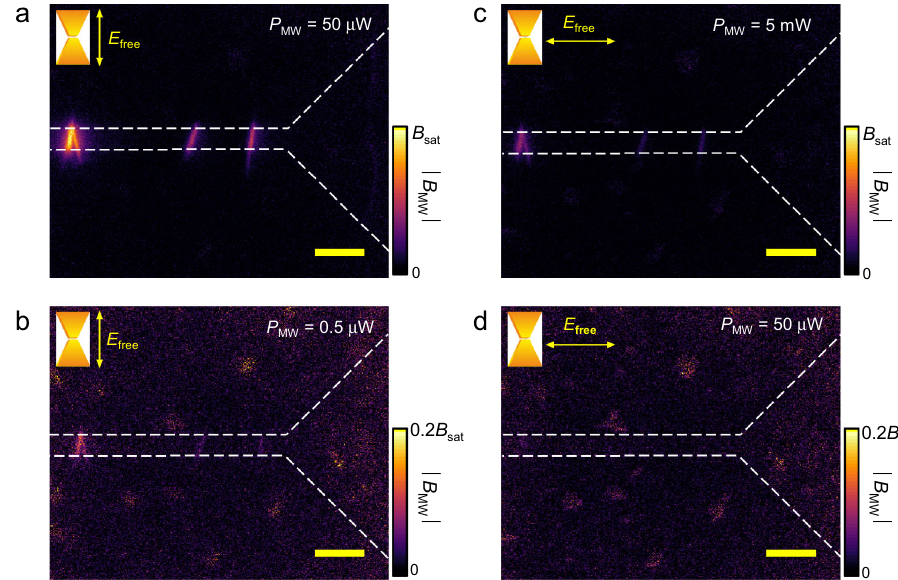
Fig. 4 The localized microwave fi eld distribution is changed with the polarization of the free-space microwave. a , b The electrical polarization of the free-space microwave is parallel to the direction of nanowire-bowtie structure. c , d The electrical polarization is perpendicular to the nanowire-bowtie structure. The results are obtained with the wide fi eld microscopy. The scale bars are 20 μ m in length. E free denotes the electrical component of the free- space